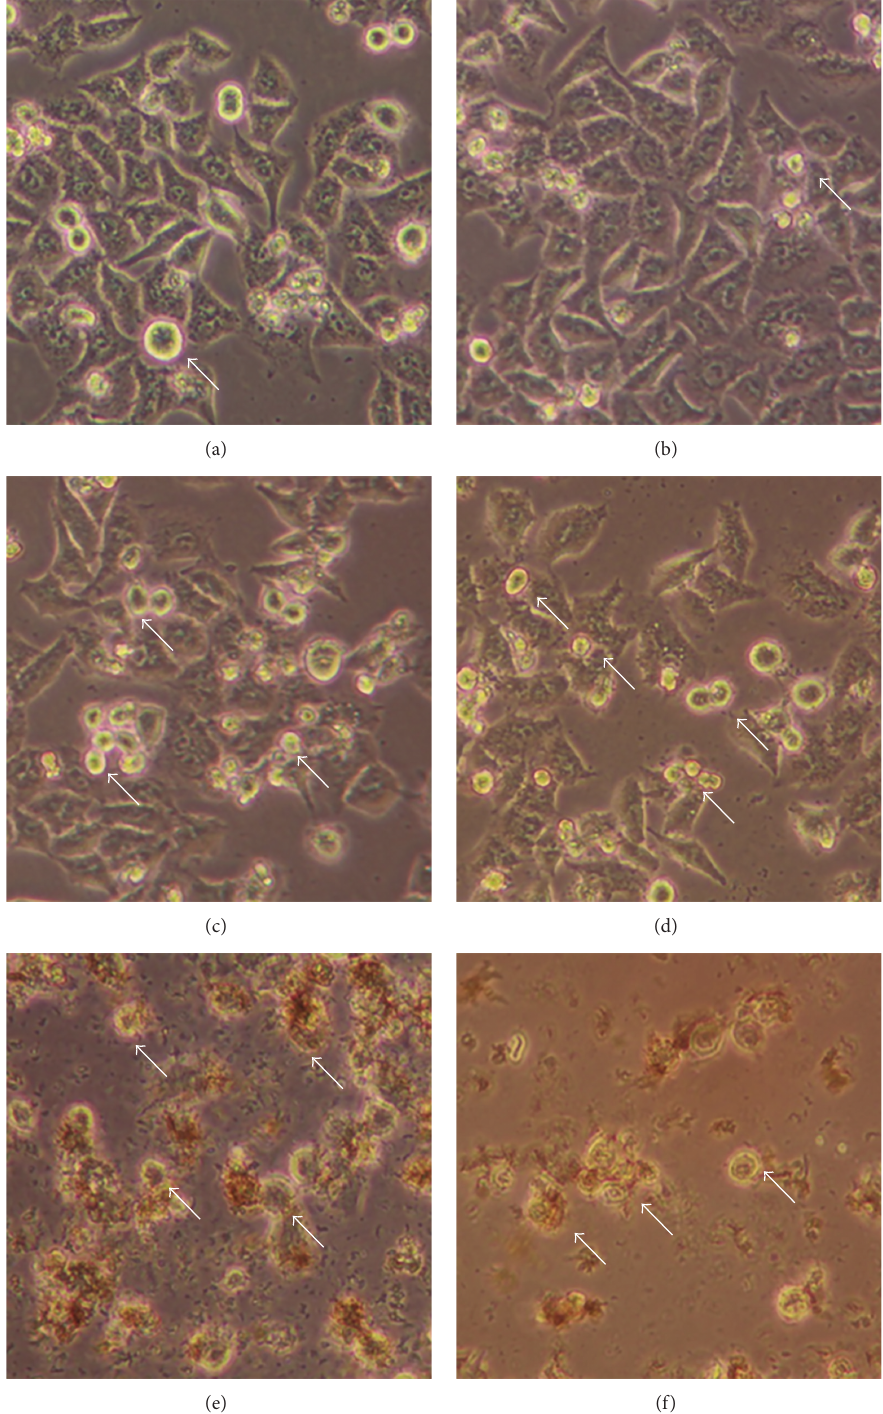
Figure 4: Morphological changes in Hep3B cells. Morphology of Hep3B cells visualized by optical microscopy ( × 100). The cells were treated with various concentrations of the Euphorbia supina polyphenol mixture for 24 h. (a) Control, (b) 31.25 mg/L, (c) 62.5 mg/L, (d) 125 mg/L, (e) 250 mg/L, and (f) 500 mg/L. White arrows indicate suspended